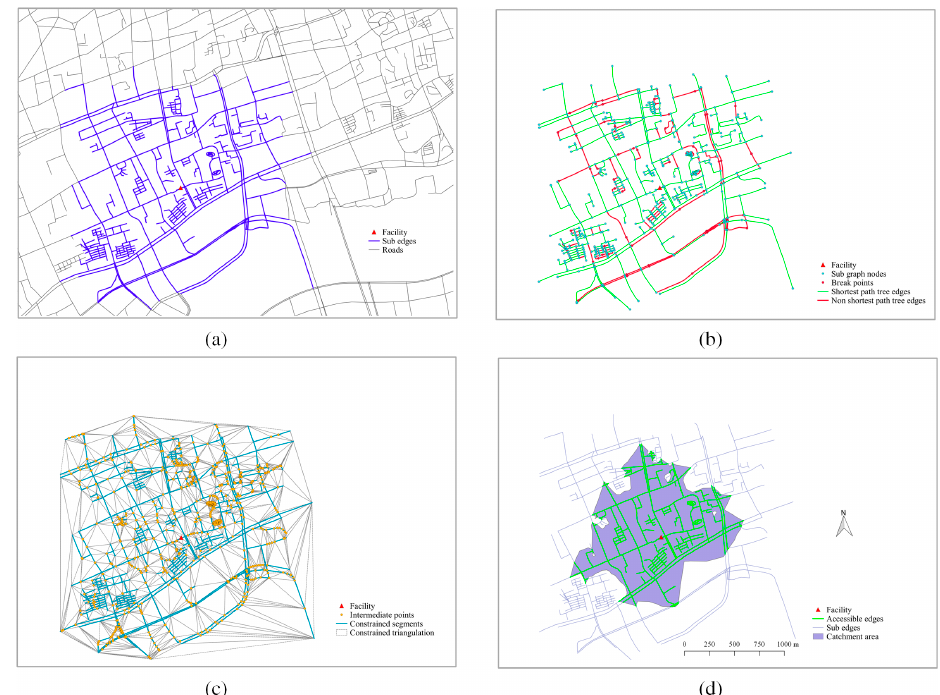
Figure 8. The process of catchment area generation of a point facility based on an undirected road network. ( a ) sub-edges; ( b ) shortest path (SP) tree and non-SP tree edges; ( c ) constrained Delaunay triangulation; ( d ) accessible edges and catchment area.